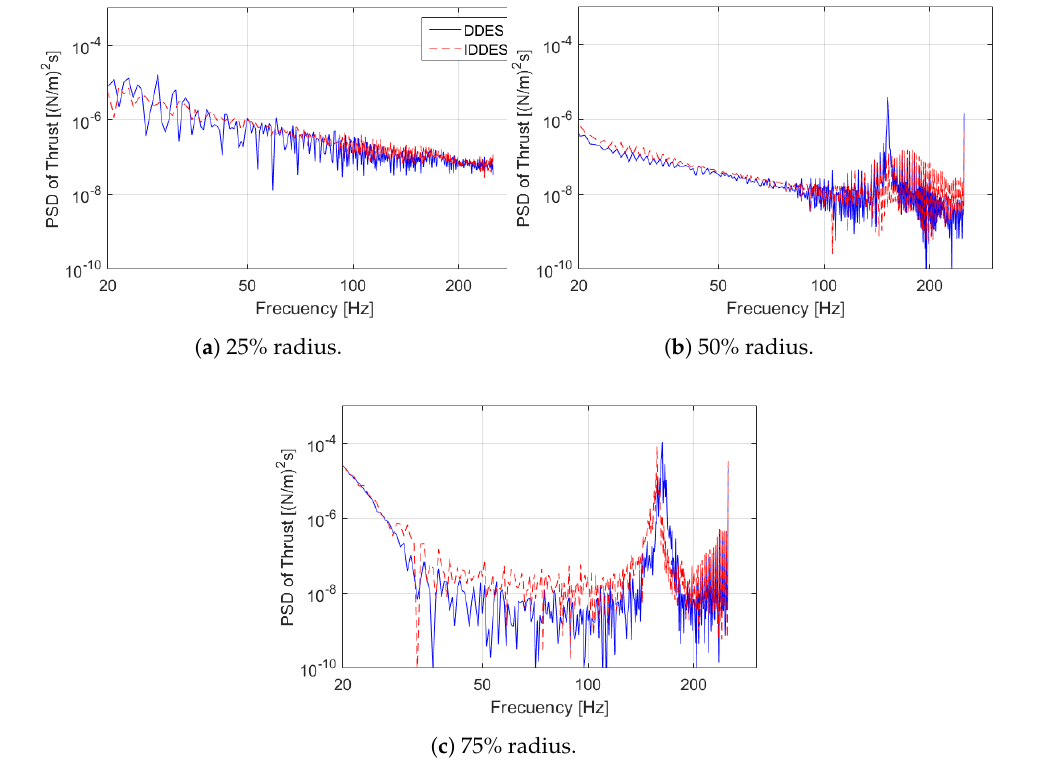
Figure 7. Power Spectral Density for the thrust normalized by blade radius, for 25%, 50% and 75% blade